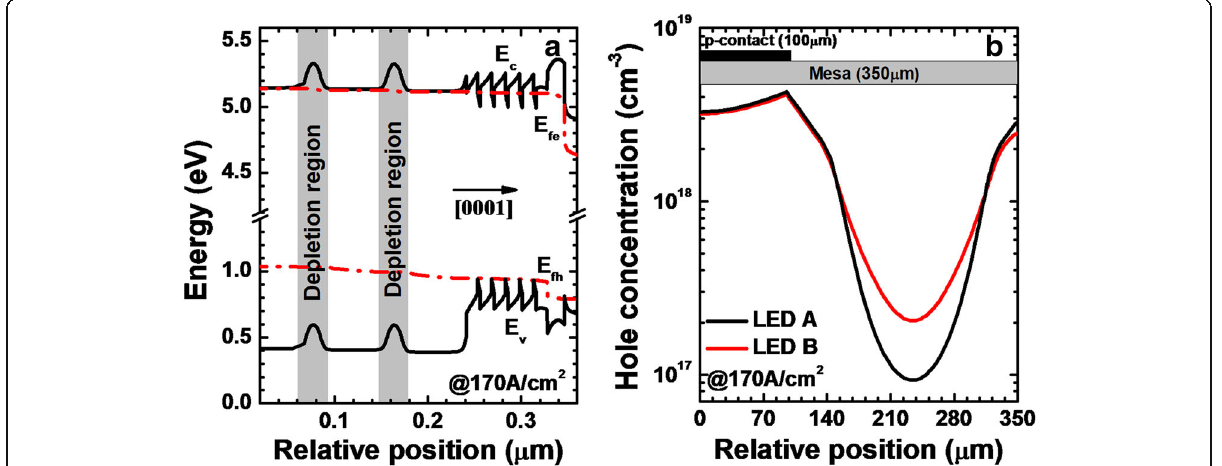
Fig. 3 a Energy band profile for LED B, in which we define the conduction band, quasi-Fermi levels for electrons and holes, and the valence band as E c , E fe , E fh , and E v , respectively. b Horizontal hole concentration in the LQW for LEDs A and B when the current density is 170 A/cm